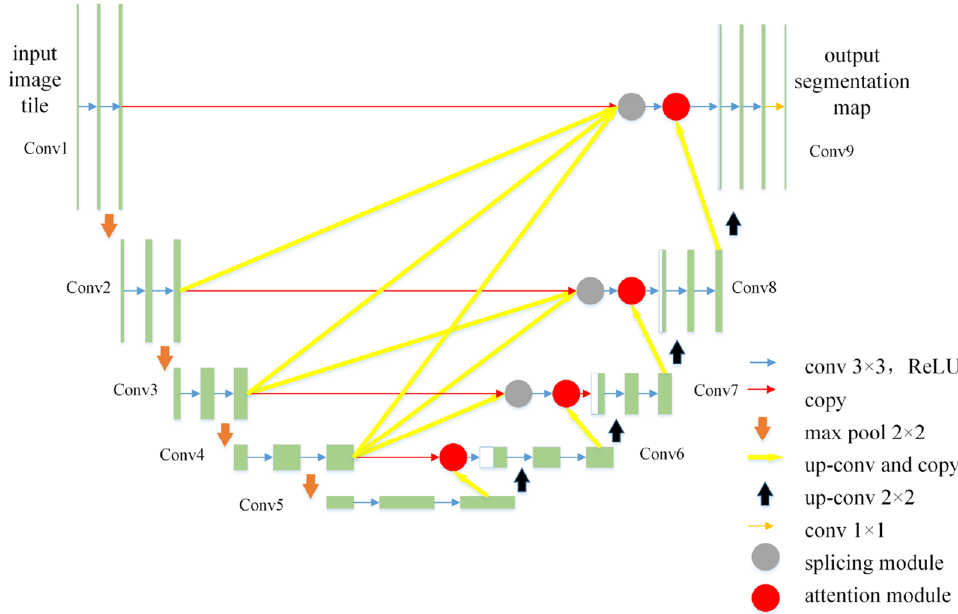
Figure 3 Structure of multi-scale splicing attention